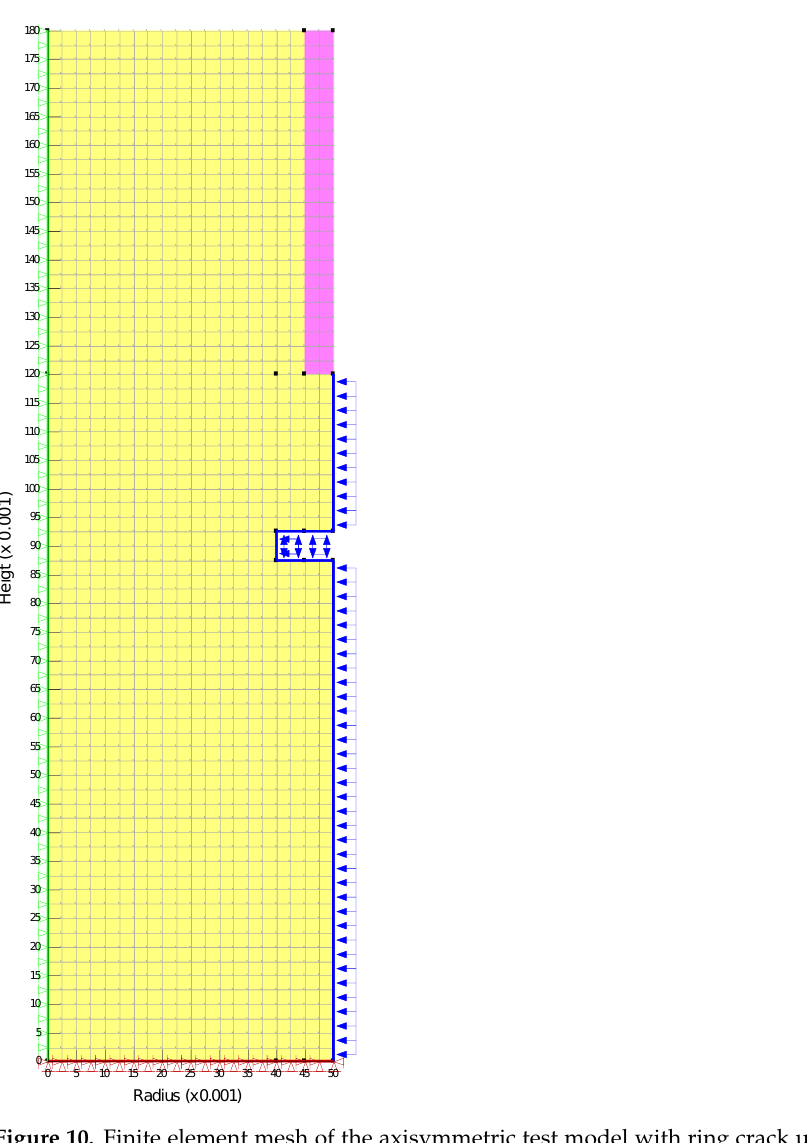
Figure 10. Finite element mesh of the axisymmetric test model with ring crack under the vertical displacement unrestraint conditions. Yellow represents asphalt concrete, while pink represents the steel sleeve. (Unit: m.)